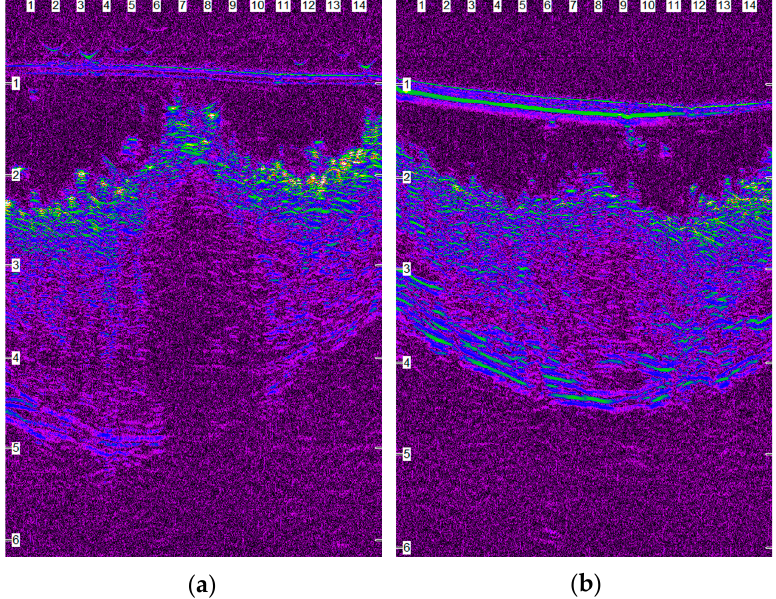
Figure 11. Ultrasonographic images of the wound area closed with glue 4 days ( a ) and intradermal 84 days ( b ) postoperatively. The image is compressed laterally to facilitate viewing (scale is in mm). Between the 15th po.d. and 42nd po.d., the u/s estimated wound area was reduced to half with all techniques. From the 40th to the 120th po.d., the wound area continued to decrease in size with all techniques. During this period the epidermis at the wound area was losing its conical shape and was becoming flat, and its density approached that of the adjacent normal tissue. The wound area was depicted more clearly with glue and intradermal compared to staples, as with the last technique the wound area was almost isoechoic to the normal adjacent skin. After the 150th po.d., the newly formed mature dermis at the wound area became almost isoechoic to the normal adjacent skin in all incisions with all techniques. In almost all incisions with all techniques, the epidermal edges at the incision site ultrasonographically seemed to be in close contact with each other, from the 1st po.d. until the last day of the experiment. Although it was difficult to monitor the progress of epithelialization with the particular ultrasound scanner, which uses frequencies of 50 MHz, a small epithelial gap was observed during the first postoperative days in some scans of the incisions closed with glue (Figure 12). The wound area was calculated for each tomographic plan. As the u/s estimated wound area differed significantly between the four different tomography planes of each incision, the mean area was calculated and used for further evaluation. The u/s estimated wound areas in each time period are presented in Figure 13. No statistically significant difference was found between techniques, except for periods B and C, where staples were found to have smaller u/s estimated wound area than intradermal ( p = 0.007 and p = 0.006,